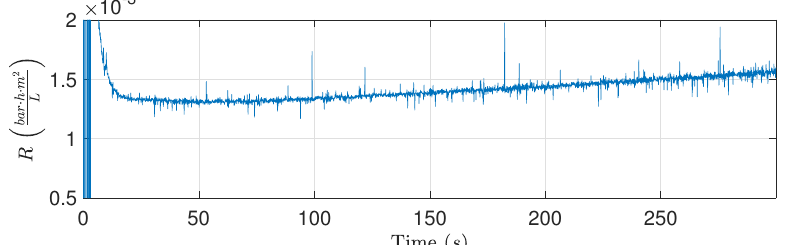
Figure 8. The estimated flow resistance is slowly increasing during backwashing. Experimental conditions: ∆ P b , ref = − 3